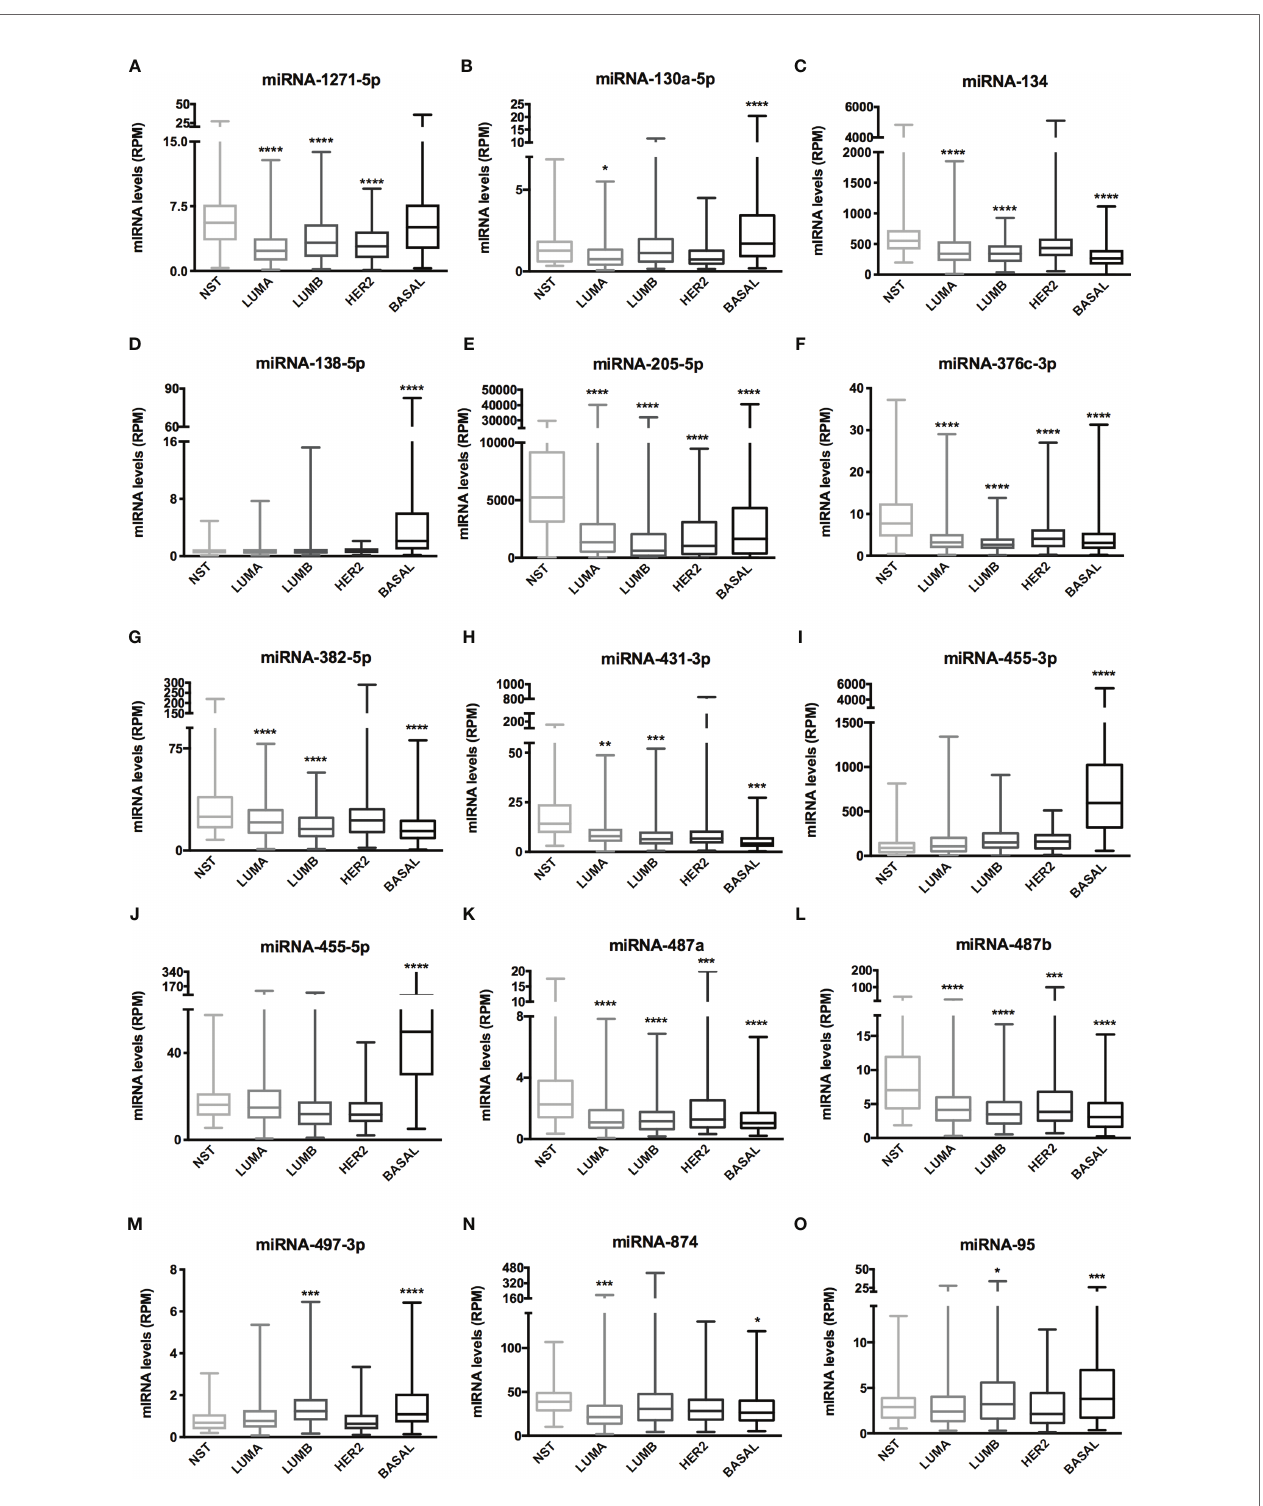
FIGURE 5 | miRNA expression of 15 miRNAs related to BC aggressiveness from TCGA dataset. Histogram analysis of miRNAs targets from the TCGA-BRCA dataset. (A) miRNA-1271-5p, (B) miRNA-130a-5p, (C) miRNA-134, (D) miRNA-138-5p, (E) miRNA-205-5p, (F) miRNA-376c-3p, (G) miRNA-382-5p, (H) miRNA-431-3p, (I) miRNA-455-3p, (J) miRNA-455-5p, (K) miRNA-487a, (L) miRNA-487b, (M) miRNA-497-3p, (N) miRNA-874, (O) miRNA-95. We collected miRNA expression data (RPM) of interest from NST, LUMA, LUMB, HER2 and BASAL subtypes. Statistical differences are related to NST group. NST, Normal Solid Tissues. *p < 0.05, **p < 0.01, ***p < 0.001, and ****p <